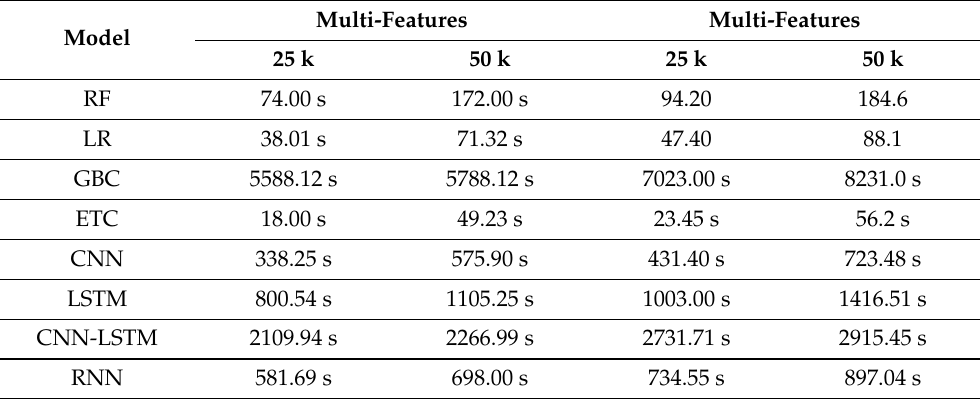
Table 14. Computational time for all models.